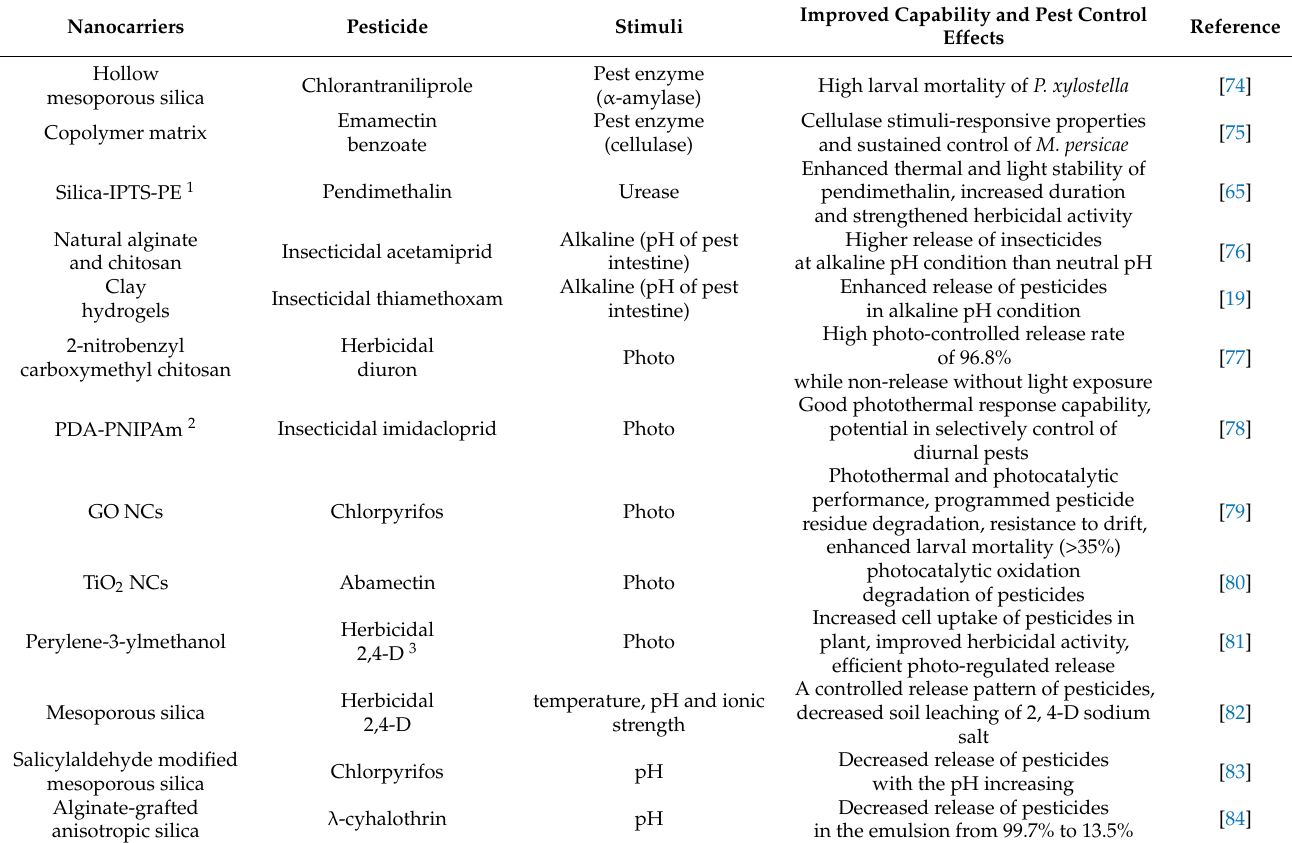
Table 3. Stimuli-responsive nanosystems and their corresponding